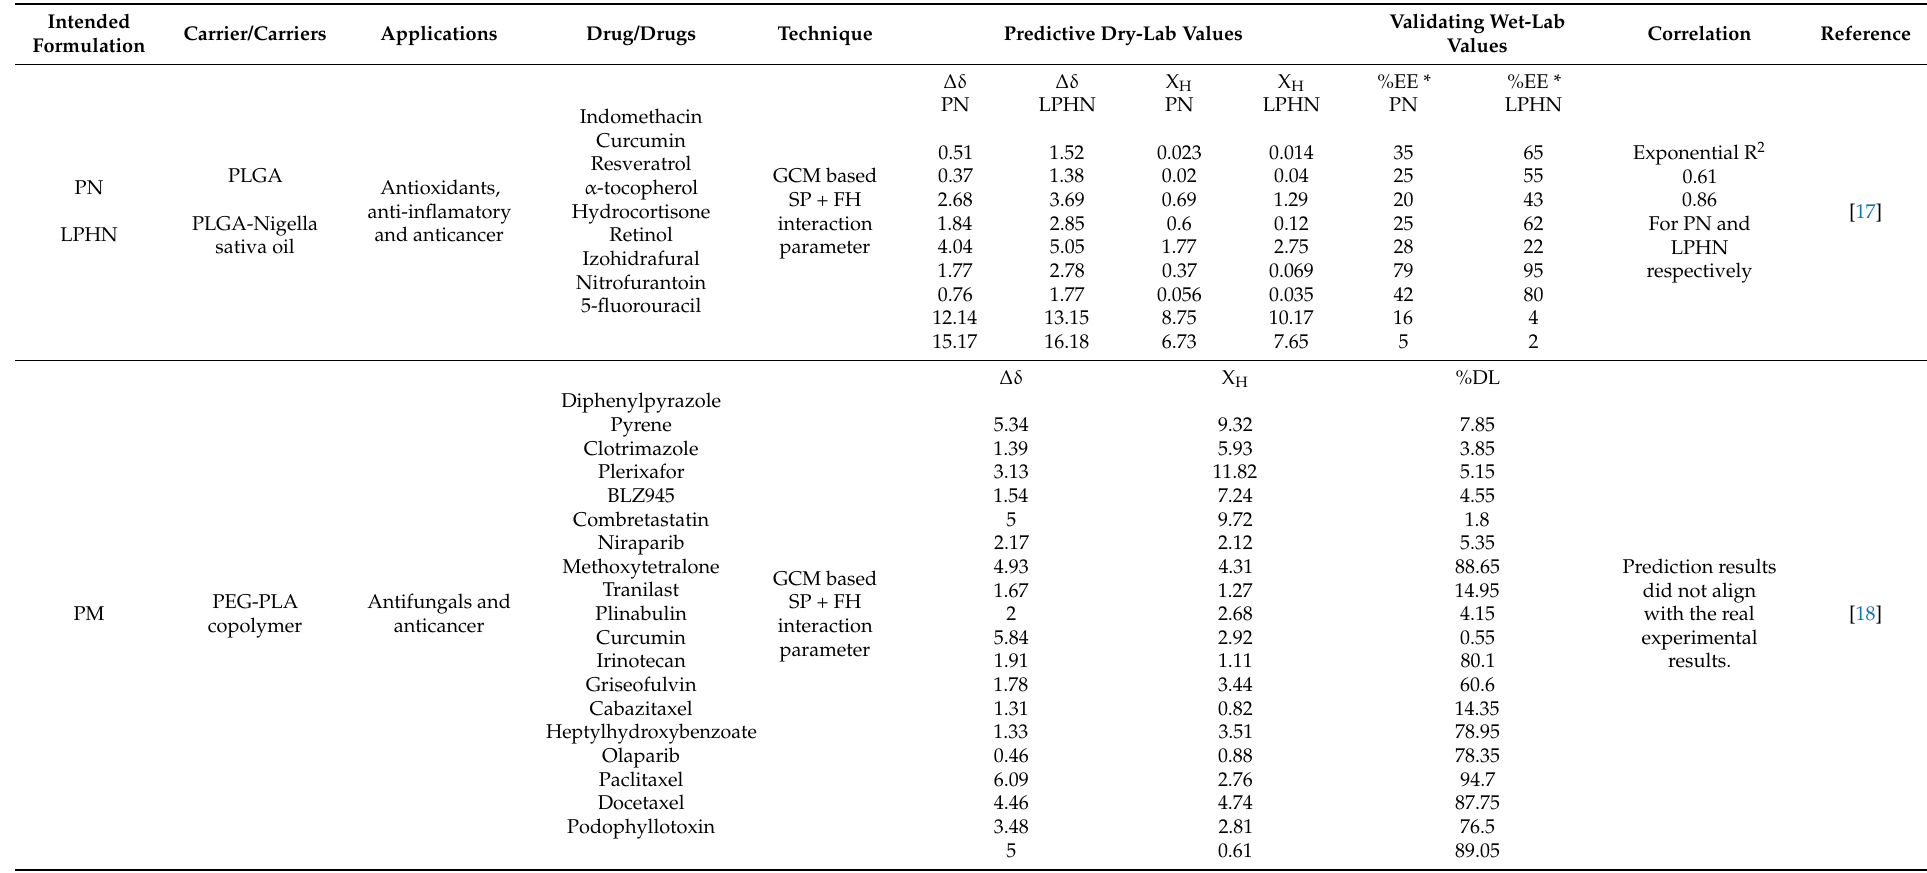
Table 1. Recent classical applications of solubility parameters and Flory-Huggins interaction theory for different lipid and polymeric nanocarriers and their main outcomes. Intended